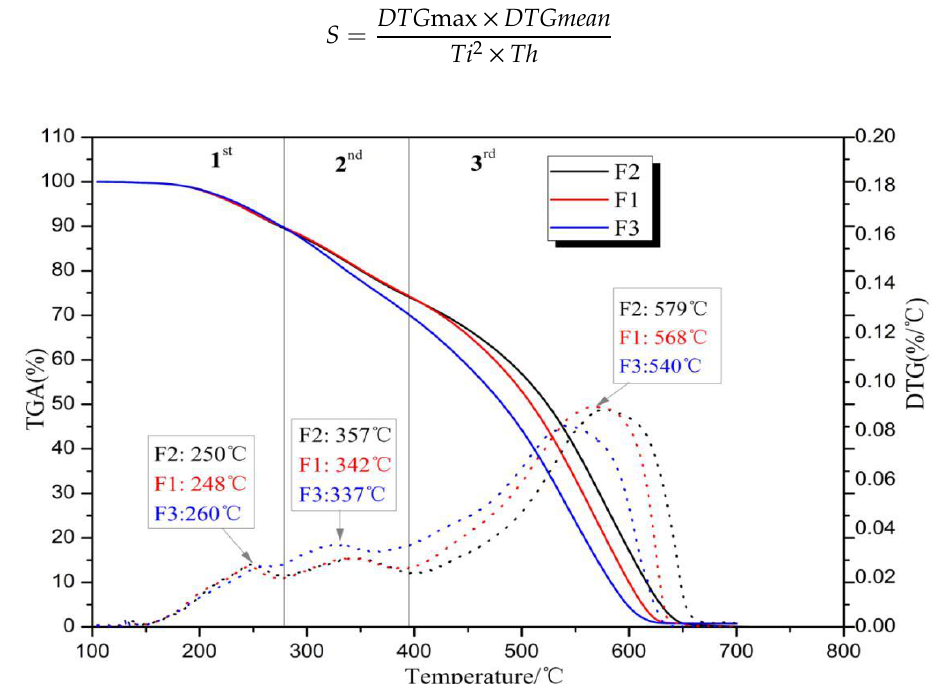
Figure 5. Thermogravimetric analysis (TGA) and derivative thermogravimetric (DTG) curves of foams in air atmosphere.